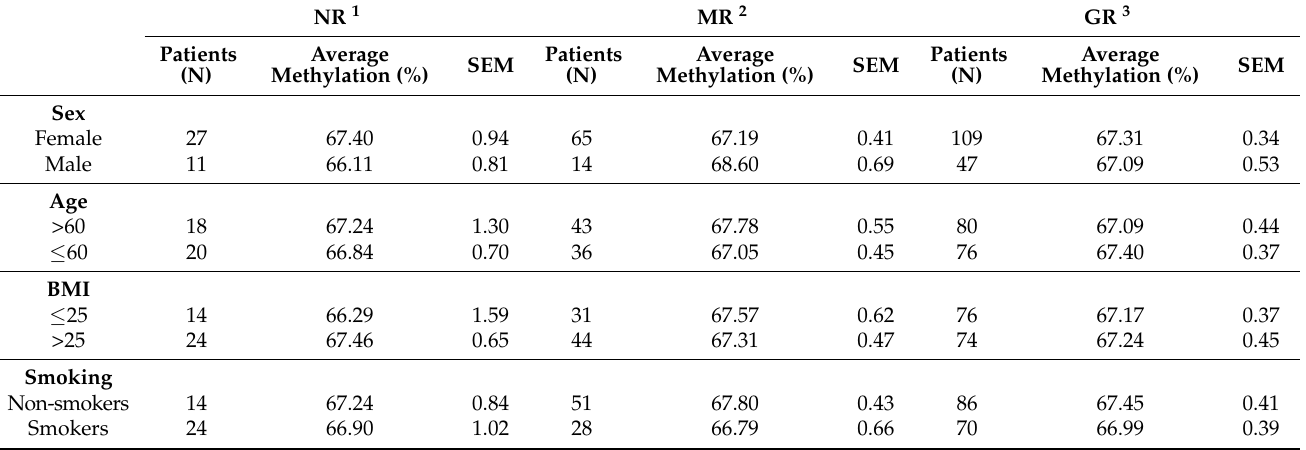
Table 3. Average LINE-1 methylation levels with response to the therapy considering sex, age, BMI, and smoking